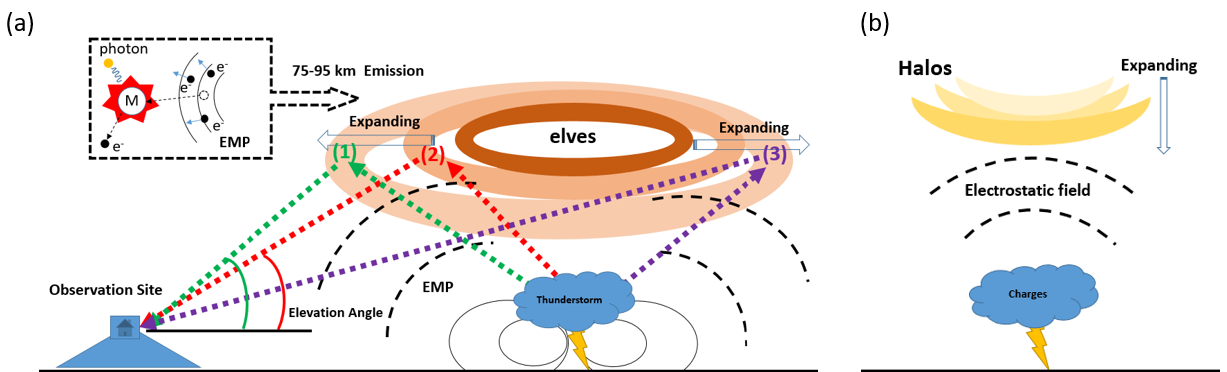
Figure 7. The cartoon pictures to illustrate the ( a ) elve and ( b ) halo generation mechanisms and their formations.